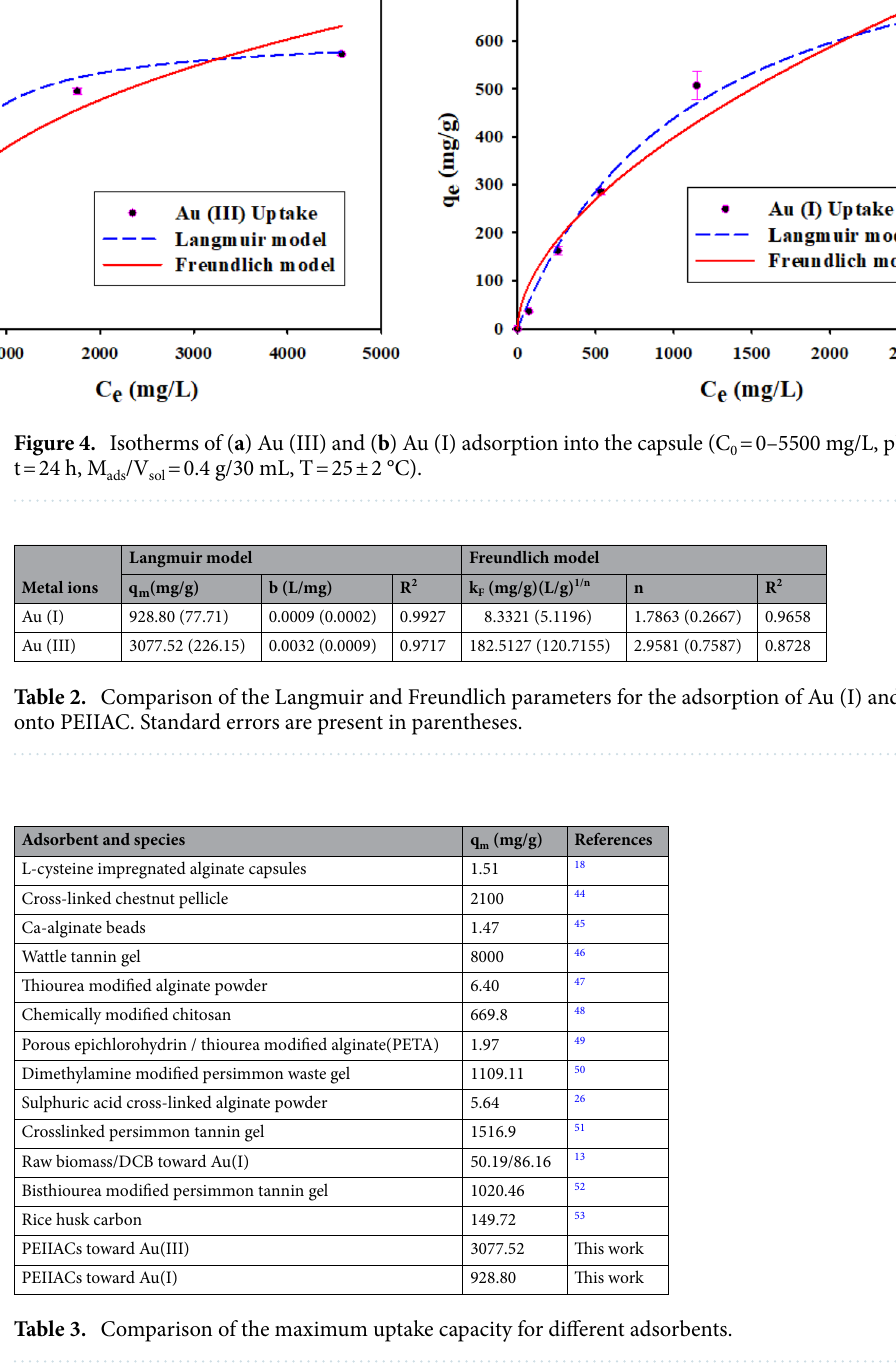
Table 3. Comparison of the maximum uptake capacity for different adsorbents.